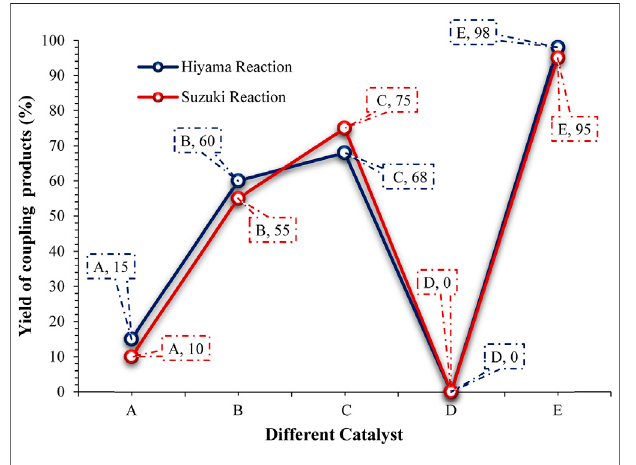
FIGURE 11 | Comparison of the performance of catalysts with each other. a Fe 3 O 4 @CNF; b Fe 3 O 4 @CNF ∼ Im; c SBL-Co (0.3 mol%); d Co(OAc) 2 .4H 2 O (0.3 mol%); e Fe 3 O 4 @CNF ∼ ImSBL ∼ Co. (0.3 mol%). Reaction conditions: Hiyama: iodobenzene (1 mmol) and triethoxyphenylsilane (1.5 mmol), and NaOH (2 mmol), Cat (except noted, 0.006 g), and H 2 O (3 ml), T (cid:1) 70 o C. Reaction conditions: Suzuki – Miyaura: iodobenzene (1 mmol) and phenylboronic acid (1 mmol), and K 2 CO 3 (2 mmol), Cat (except noted, 0.006 g), and H 2 O (3 ml), T (cid:1) 80 o